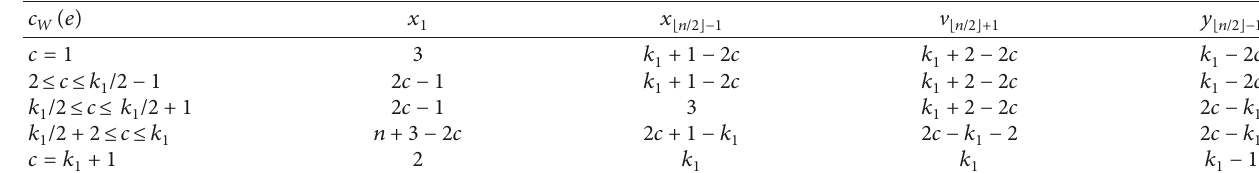
y c is c c , when